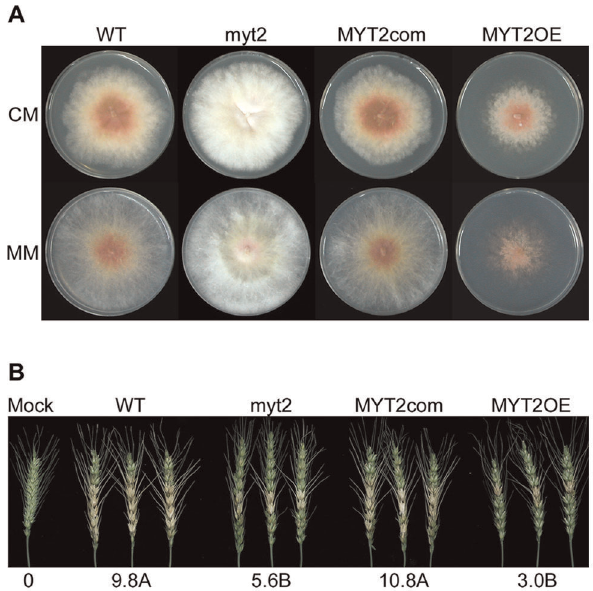
Figure 5. Mycelia growth and wheat head virulence of the MYT1 mutants. (A) Mycelial growth on complete media (CM) and minimal media (MM) 5 d after inoculation. (B) A center spikelet of each wheat head was injected with 10 m l of conidia suspension. Values with different letters are significantly different ( p , 0.05) based on Tukey’s test. Mock, negative control mock inoculated with 0.01 % Tween 20; WT, G. zeae wild-type strain Z-3639; myt2, MYT2 deletion mutant; MYT2com, myt2 - derived strain complemented with MYT2 ; MYT2OE, transgenic strain that has the EF1 a promoter in place of the MYT2 promoter region. Figure 6. Total trichothecene (deoxynivalenol and 15-acetyl-